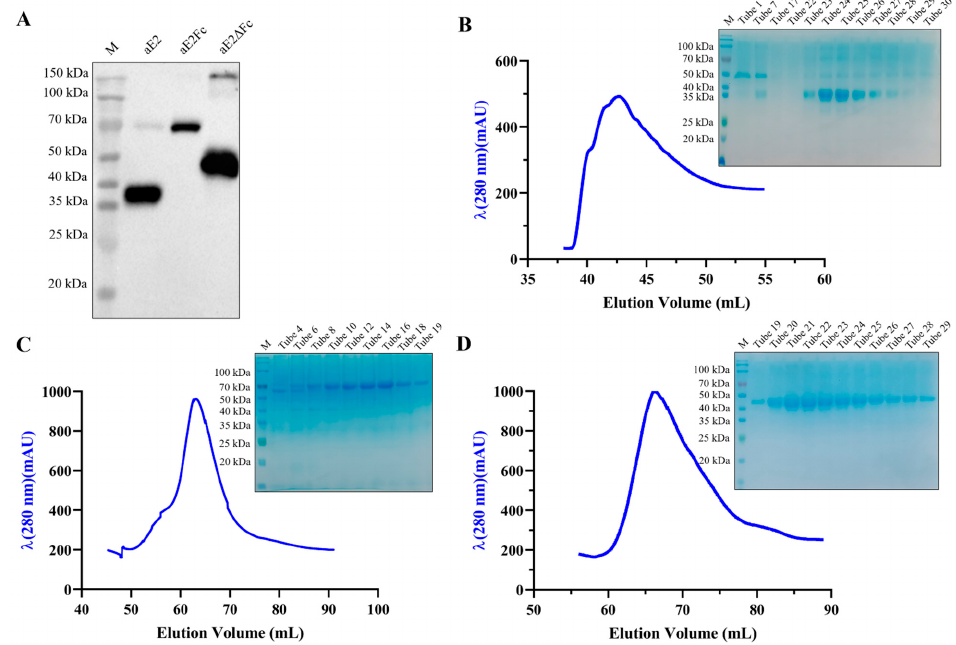
Figure 2. Purification of APPV E2, E2Fc, and E2 Δ Fc fusion proteins from S2 cells. ( A ) Western blotting analysis of APPV E2, E2Fc, and E2 Δ Fc proteins before purification. Elution peak curve of APPV E2 ( B ), E2Fc ( C ), and E2 Δ Fc ( D ) fusion proteins. The SDS-PAGE profiles were shown in the upper right corner of the elution curve. The S2 cell lines, which stably express APPV E2, E2Fc, and E2 Δ Fc proteins, were induced by CuSO 4 and cultured at 27 °C for 4 days. M, protein marker.